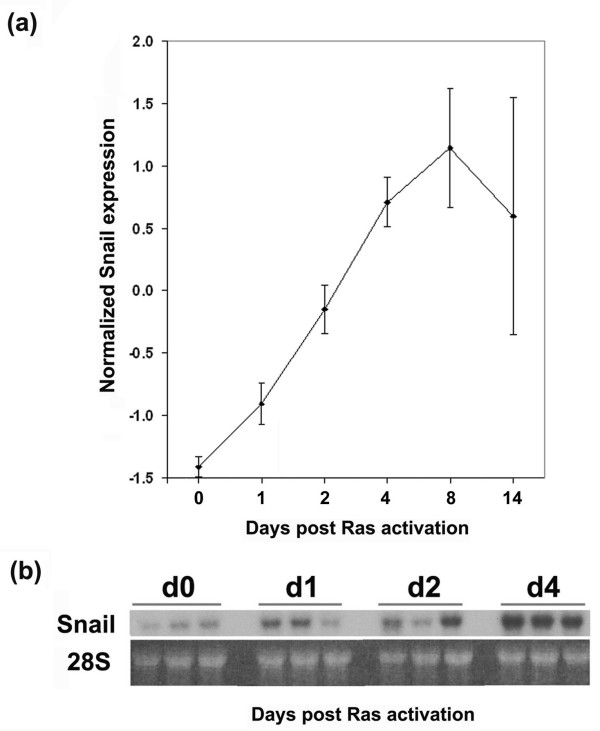
Upregulation of Snail by Ras activation. (a) Normalized microarray expression profiling (mean ± SEM) or (b) Northern hybridization analysis of Snail expression as a function of oncogenic Ras activation.